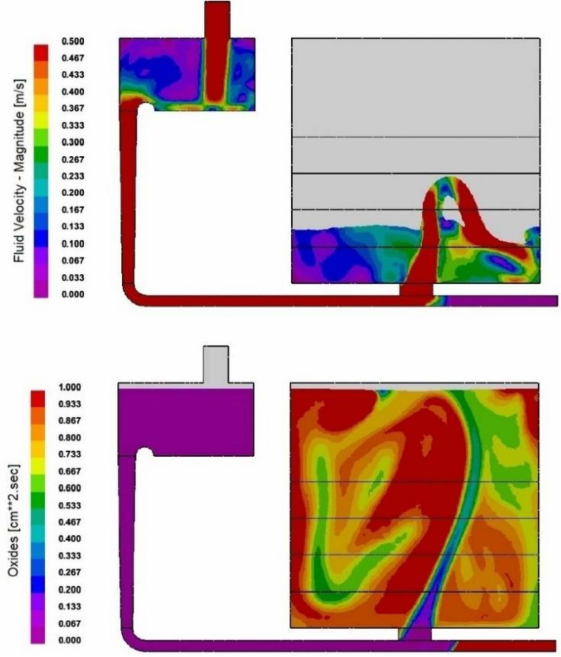
Figure 5. Simulations of the melt velocity and amount of oxides in the naturally pressurized gating system without foam